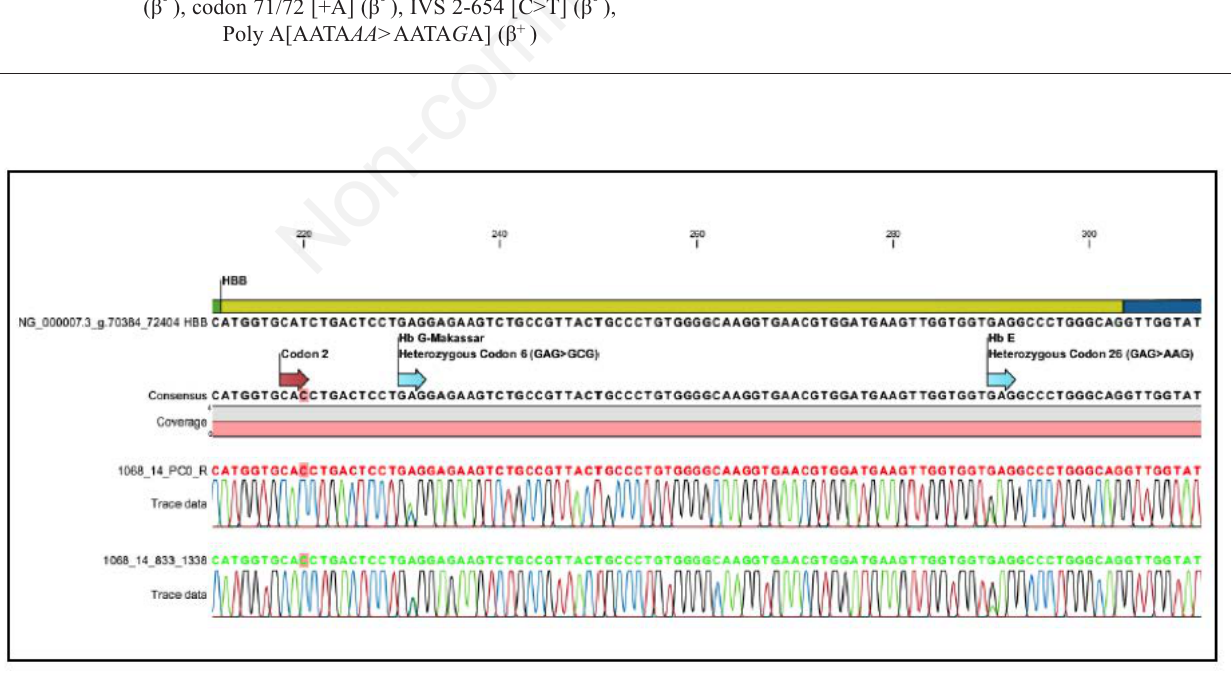
Figure 4. Direct genomic sequencing results of Makassar and codon 26 [GAG -> AAG] Hb E (